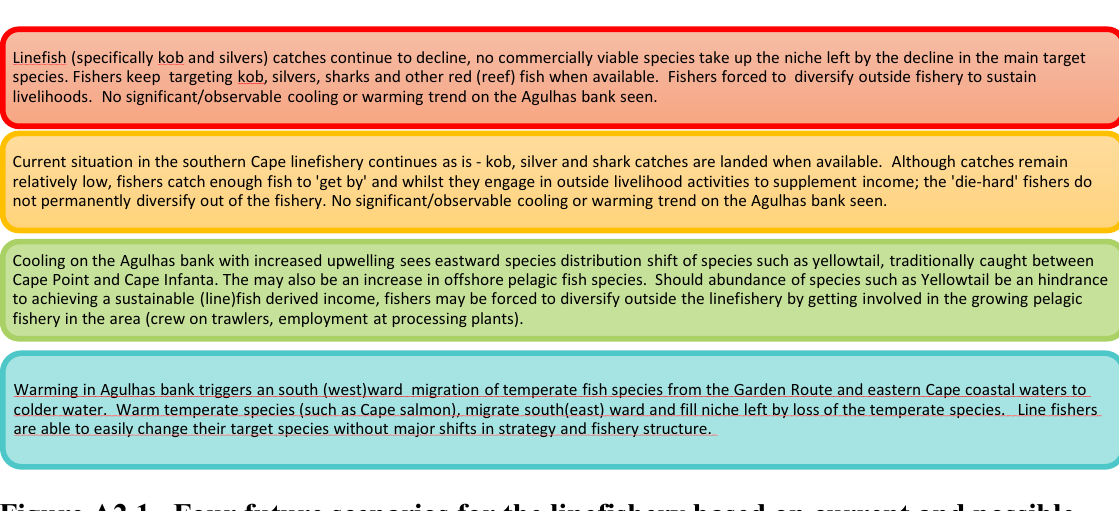
Figure A2.1. Four future scenarios for the linefishery based on current and possible future species distribution and abundance changes in the Agulhas Bank. Warming and cooling trends in the Agulhas bank have been